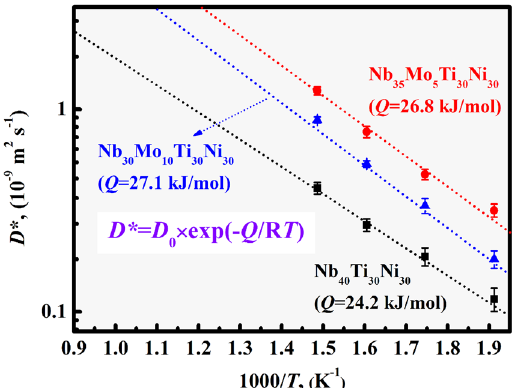
Figure 9. Temperature dependence of the average D * , shown in the form of an Arrhenius plot for as-cast Nb 0 ) in each case were determined by linear